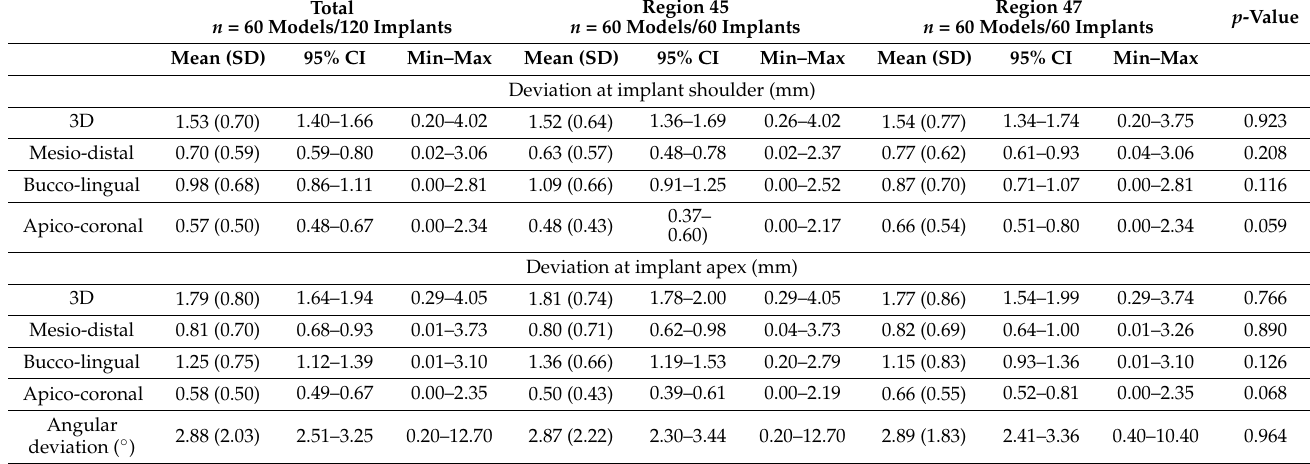
Table 2. Deviations between the planned and clinically-achieved implant positions. Total n = 60 Models/120